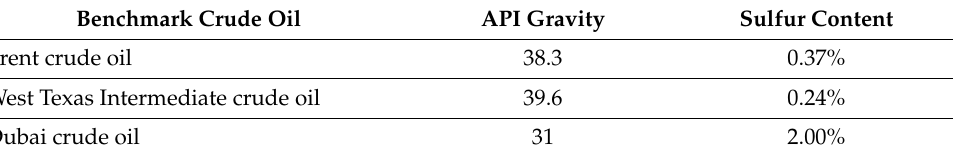
Table 1. The API gravity and Sulfur content of three benchmark crude oil.